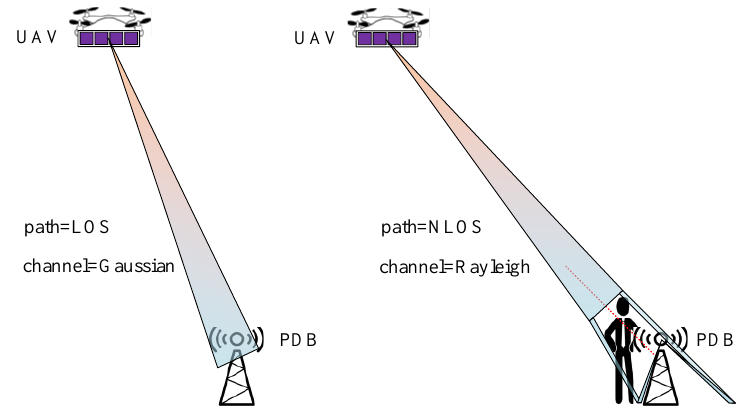
Figure 4. Line-of-sight (LOS) and non-line-of-sight (NLOS) scenes in a communication